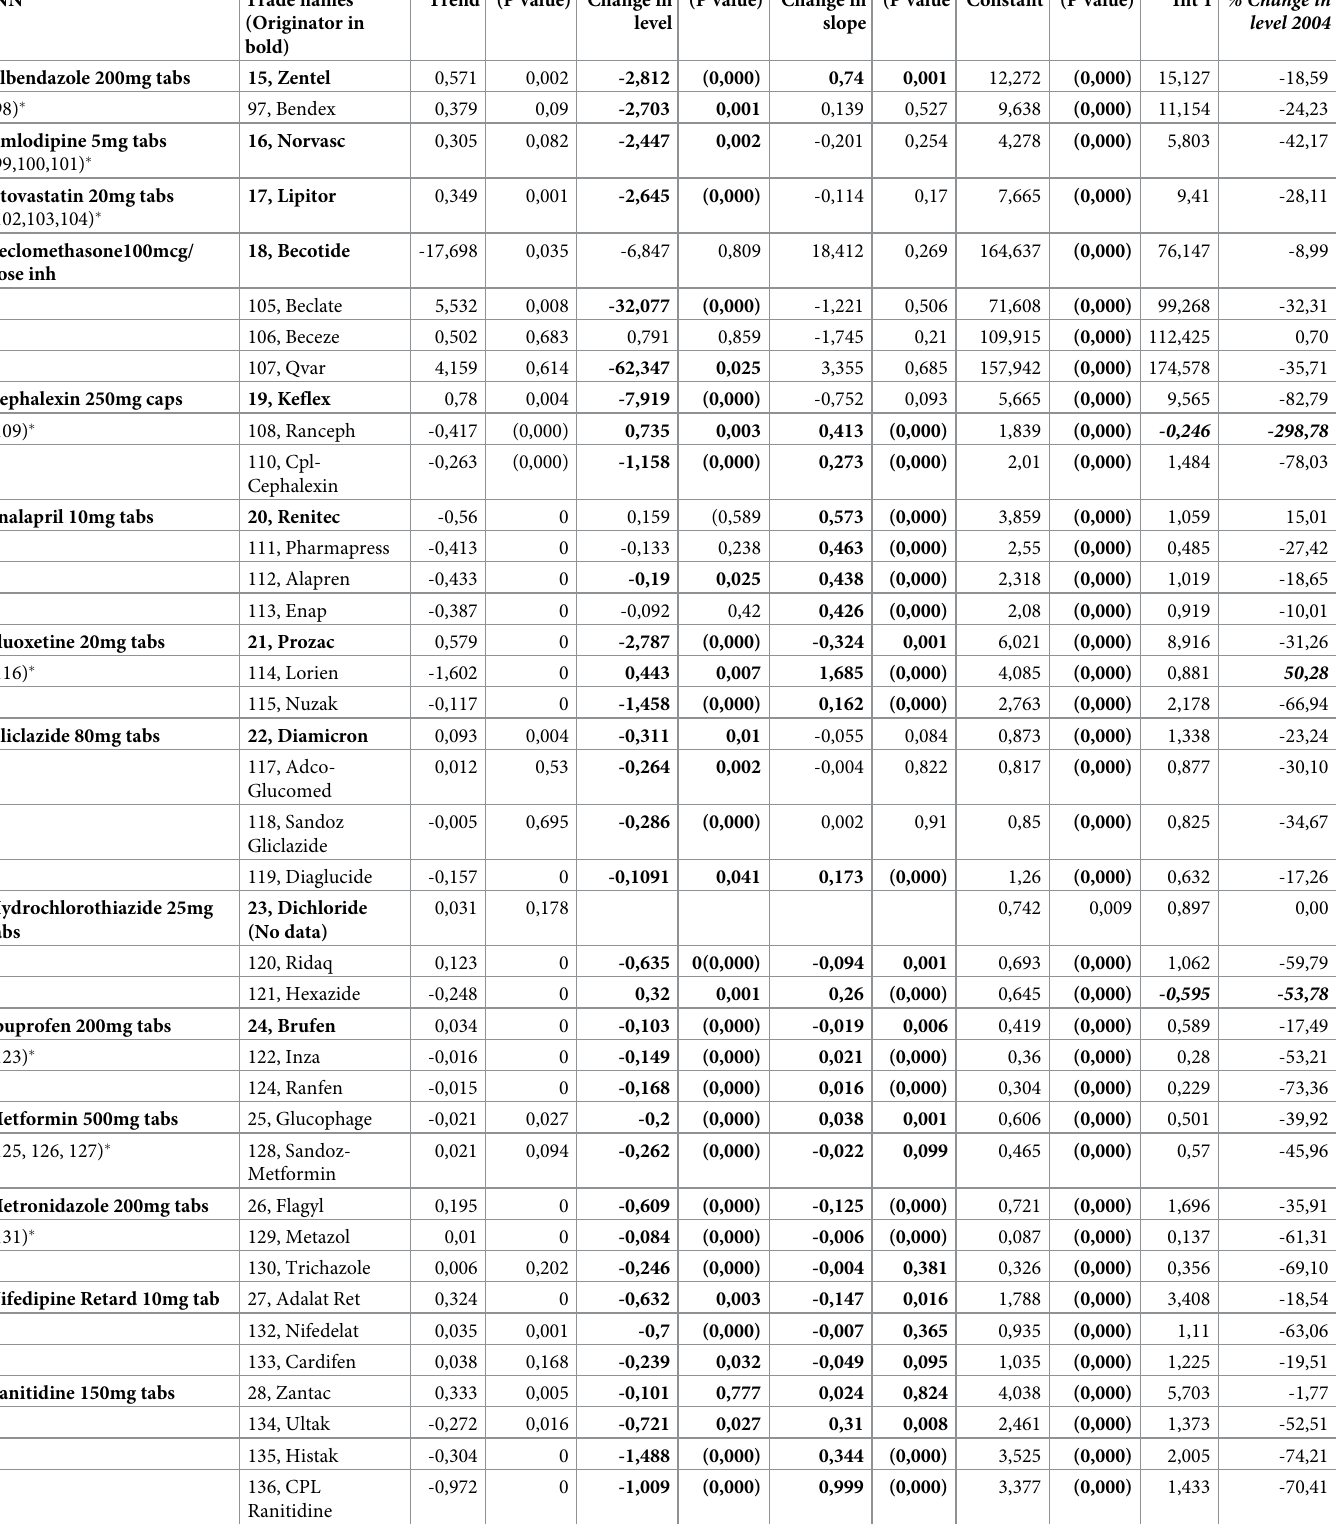
Table 2. Regional core interrupted time-series analysis for originator and generic molecules using pricing data from 1999 to 2014 with 2004 as the interruption in the series. Statistically significant values (P <